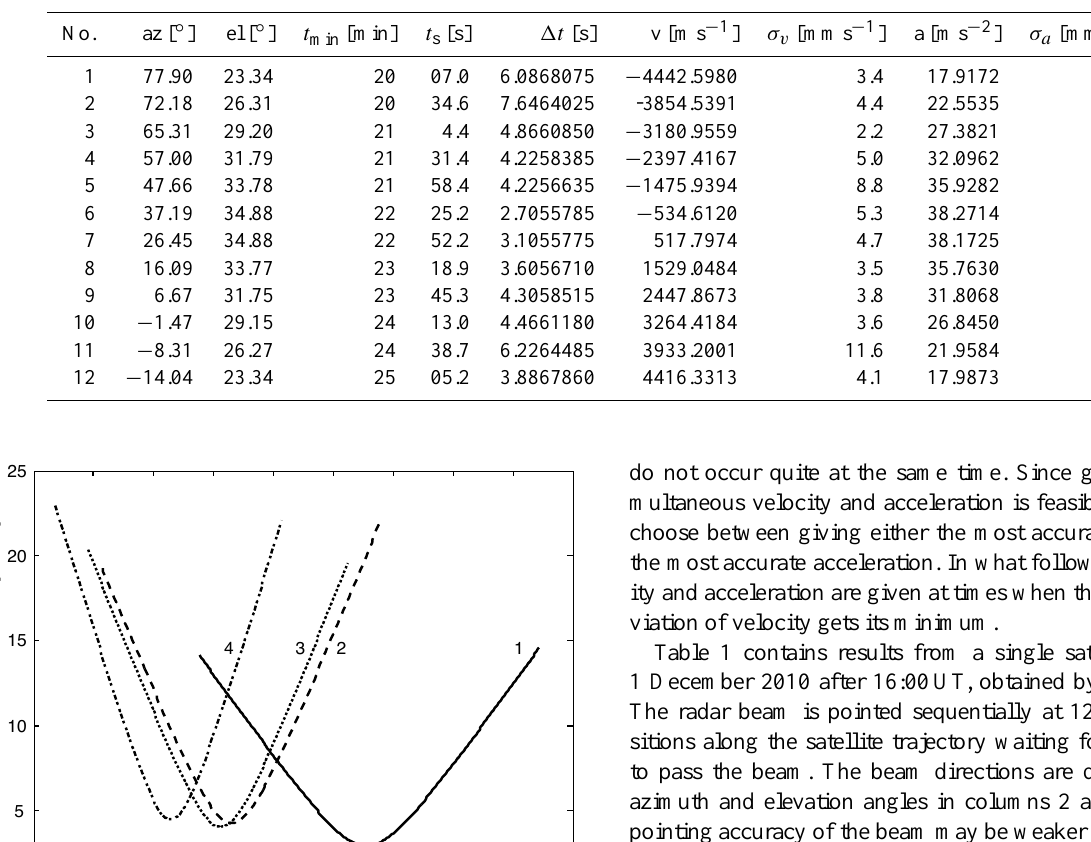
Table 1. Results from 12 beam passes on 1 December 2010, after 16:00UT. The beam passes are numbered from 1 to 12. The next two columns show the beam azimuths and elevations, t min and t s give the start times of the IPPs in minutes and seconds, 1t gives the times after the start of the IPPs, and the last four columns contain the line-of-sight velocities and accelerations with their standard deviations. The examples in Fig. 4 are from beam passes 1, 12, 10 and 8.